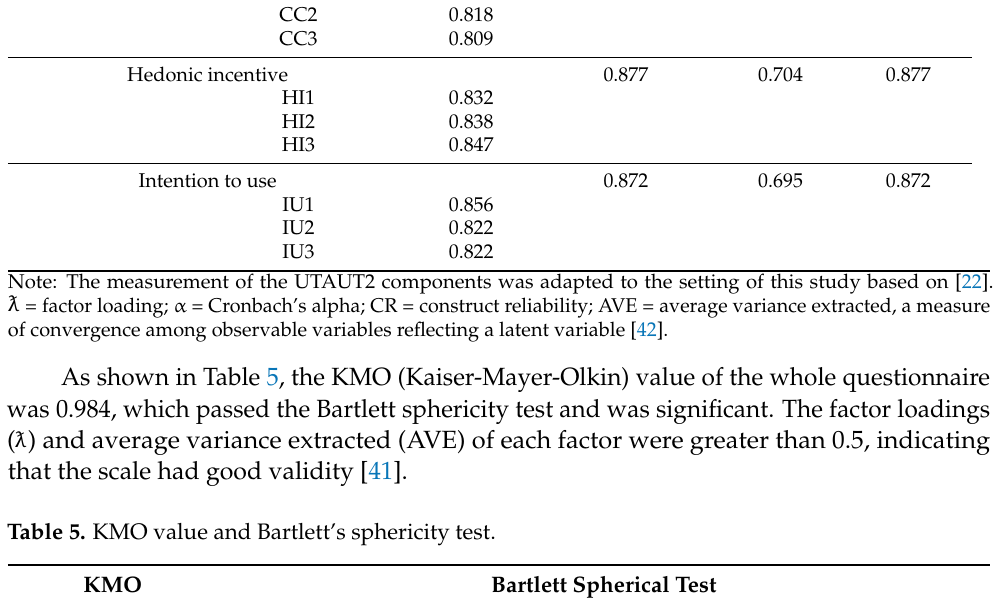
Table 6. Latent variable correlation. Table 5. KMO value and Bartlett’s sphericity test.